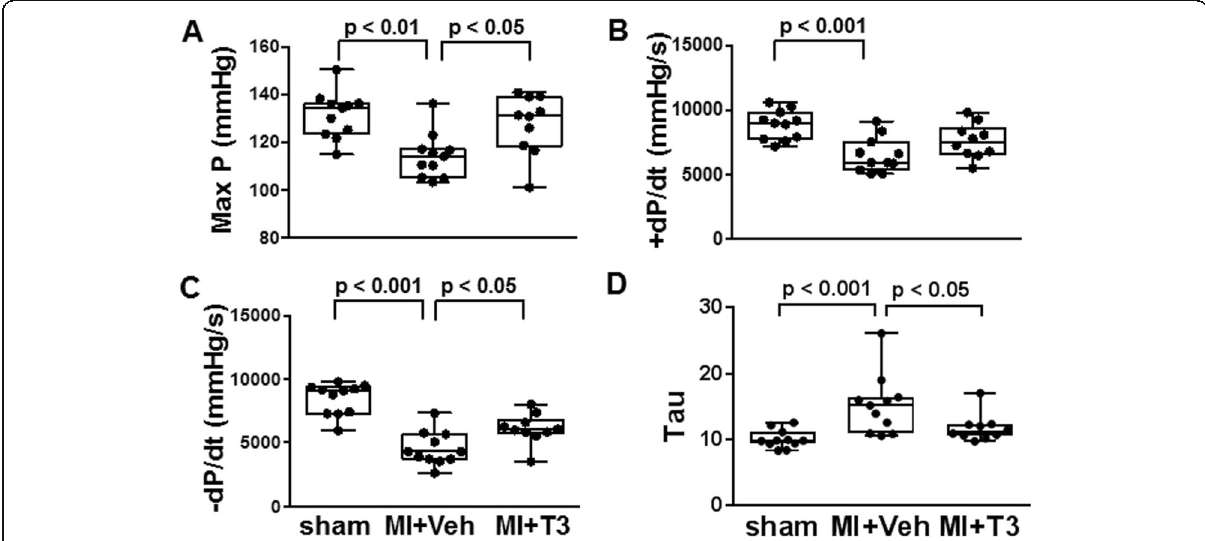
Fig. 2 Left ventricular pressure measurements. Box-and-whisker plots indicate median value, box at 25th/75th percentile, and whiskers are max/ min values; dots represent values from individual animals. a Max P, maximum developed LV pressure; first derivative of LV pressure curve during systole ( b ) + dP/dt, and diastole ( c ) – dP/dt; ( d ) Tau, exponential decay time constant in diastole. Statistical analysis by one-way ANOVA with Tukey post hoc multi-group analysis; p -values between groups are